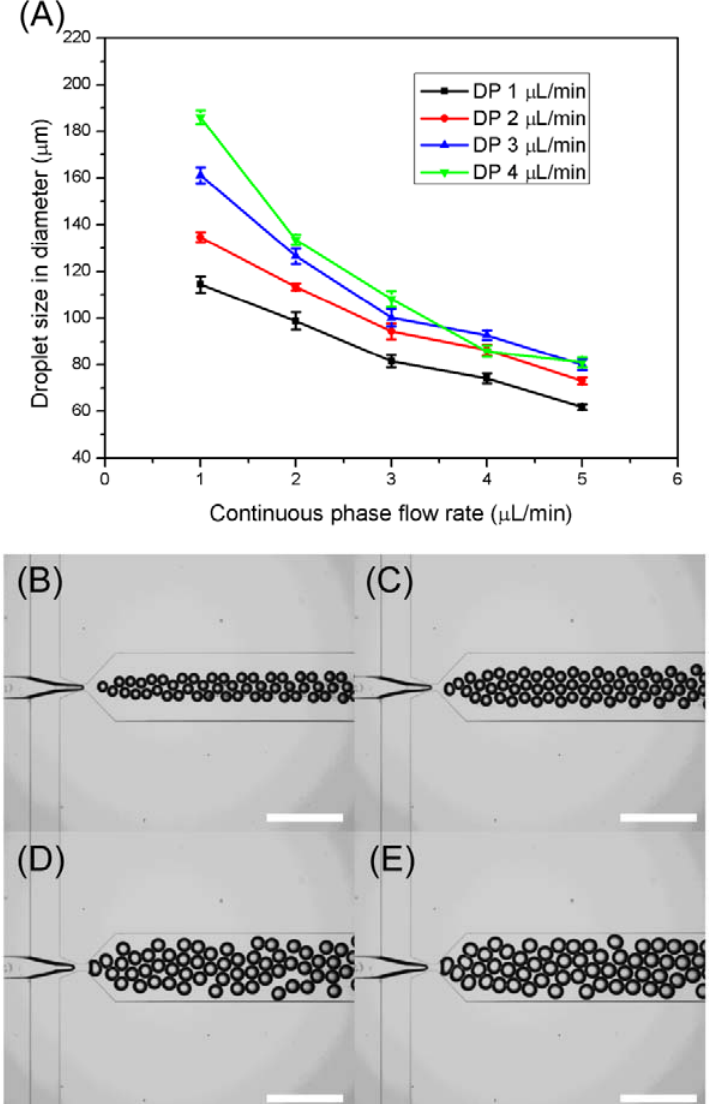
Figure 2. ( A ) Droplet size variation graph with both different flow rates of CP flow rate (1–5 μ L/min) and DP (1–5 μ L/min). Optical microscopic images of microdroplet generation at the fixed CP (2 μ L/min) with four different flow rates of